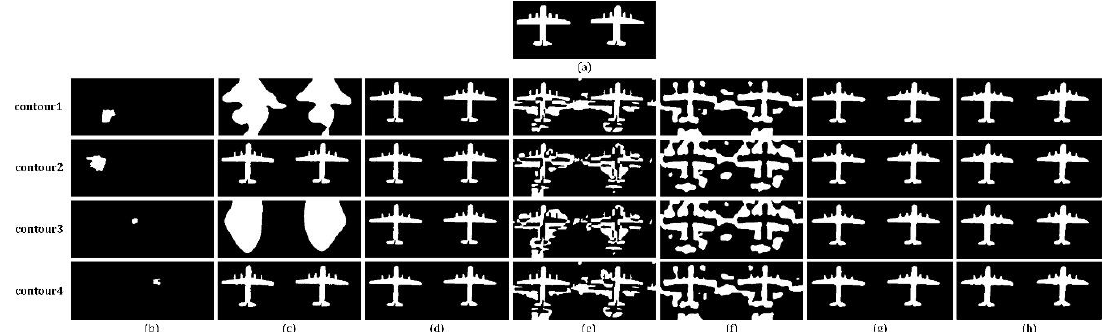
Figure 18. Binary segmentation results of ‘man’ image: ( a ) ground truth; ( b ) GAC; ( c ) CV; ( d ) SBGFRLS; ( e ) LBF; ( f ) ILFE; ( g ) Cao’s model; ( h ) the proposed method.